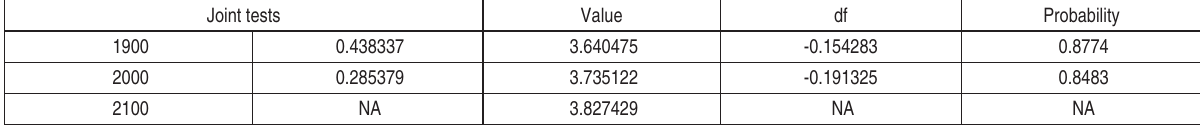
Table 5 (cont.). Results of the variance ratio test DSE ALSI daily data